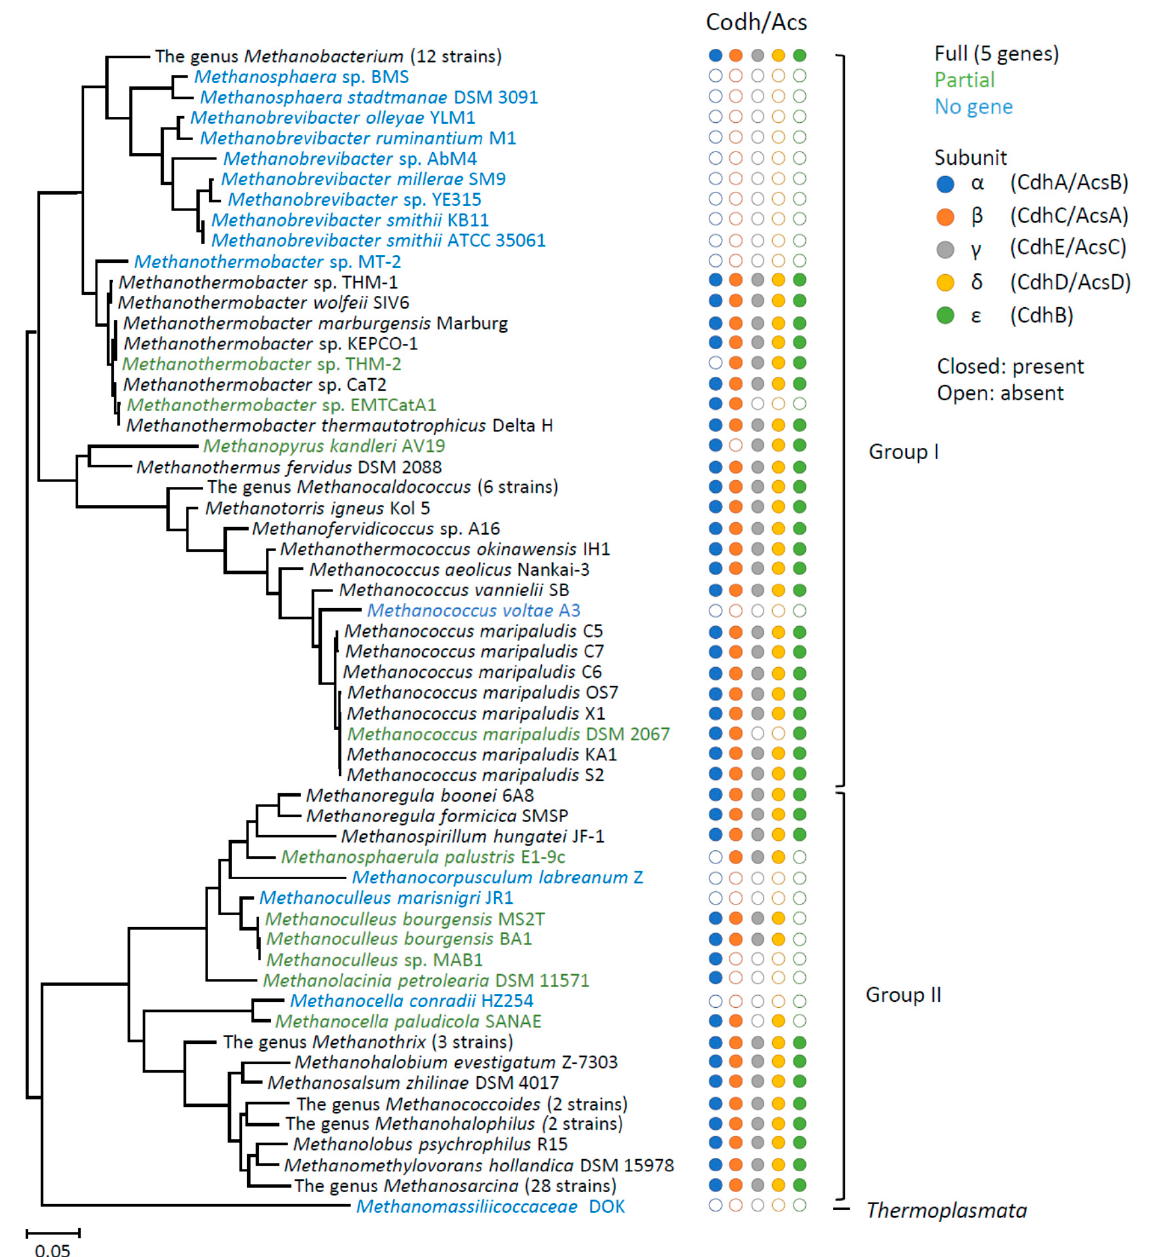
Figure 3. A phylogenetic tree showing relationships among genome-completed methanogens and distribution of the Codh/Acs genes. The tree was constructed using the neighbor-joining algorithm based on 16S rRNA gene sequences. Names are color-coded according to the presence and absence of Codh/Acs genes, in which black letters indicate methanogens possessing the complete set of the Codh/Acs genes, green letters indicate methanogens possessing partial sets, while blue letters indicate methanogens that completely lost the Codh/Acs genes. Subunits of Codh/Acs are indicated with different color circles. Closed circles indicate the presence of genes, while open circles indicate the absence.